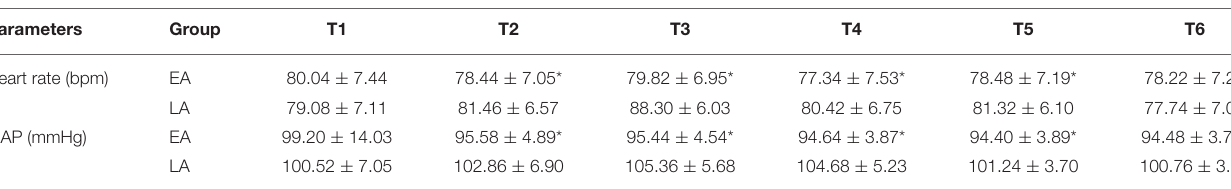
Data are present as mean ± SD. bpm, beat per minute; MAP, Mean arterial pressure; EA, Epidural anesthesia; LA, Local anesthesia; * P < 0.05.